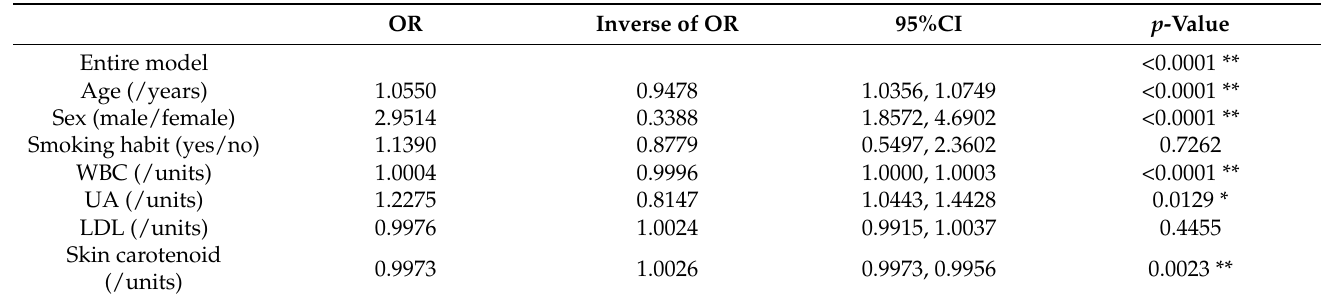
Table 3. Multiple regression analysis for risk factors of metabolic syndrome.